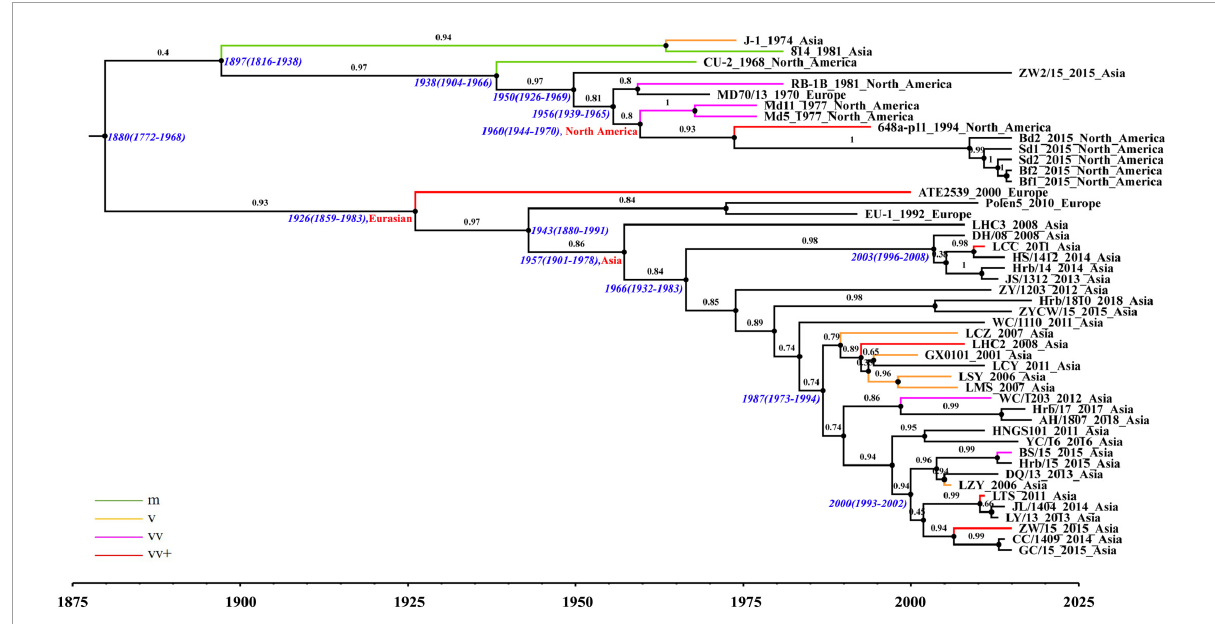
FIGURE2 Maximum clade credibility (MCC) tree of Marek’s disease virus (MDV) strains based on complete genomic sequences using the evolutionary model GTR + (cid:48)